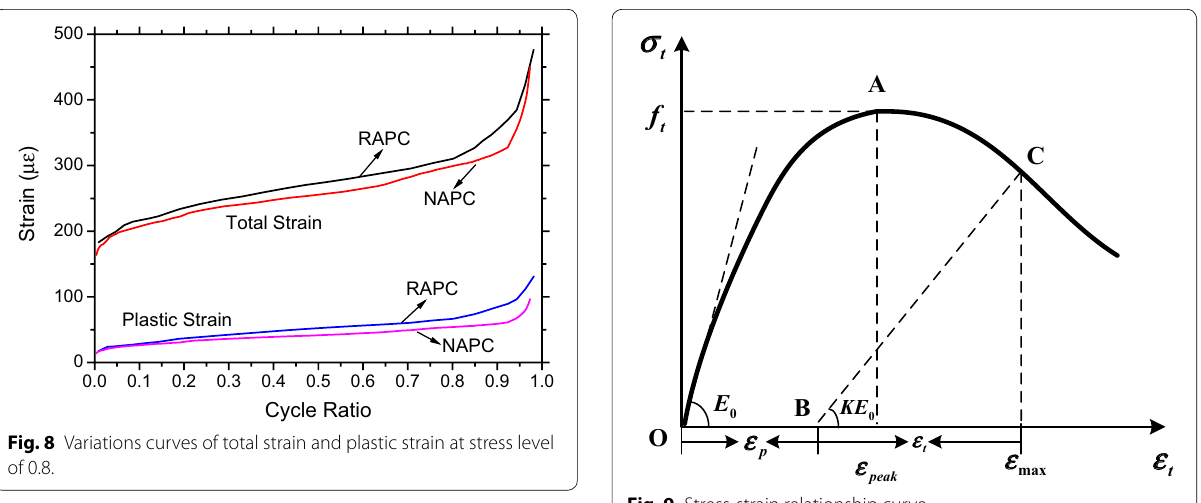
Fig. 9 Stress-strain relationship